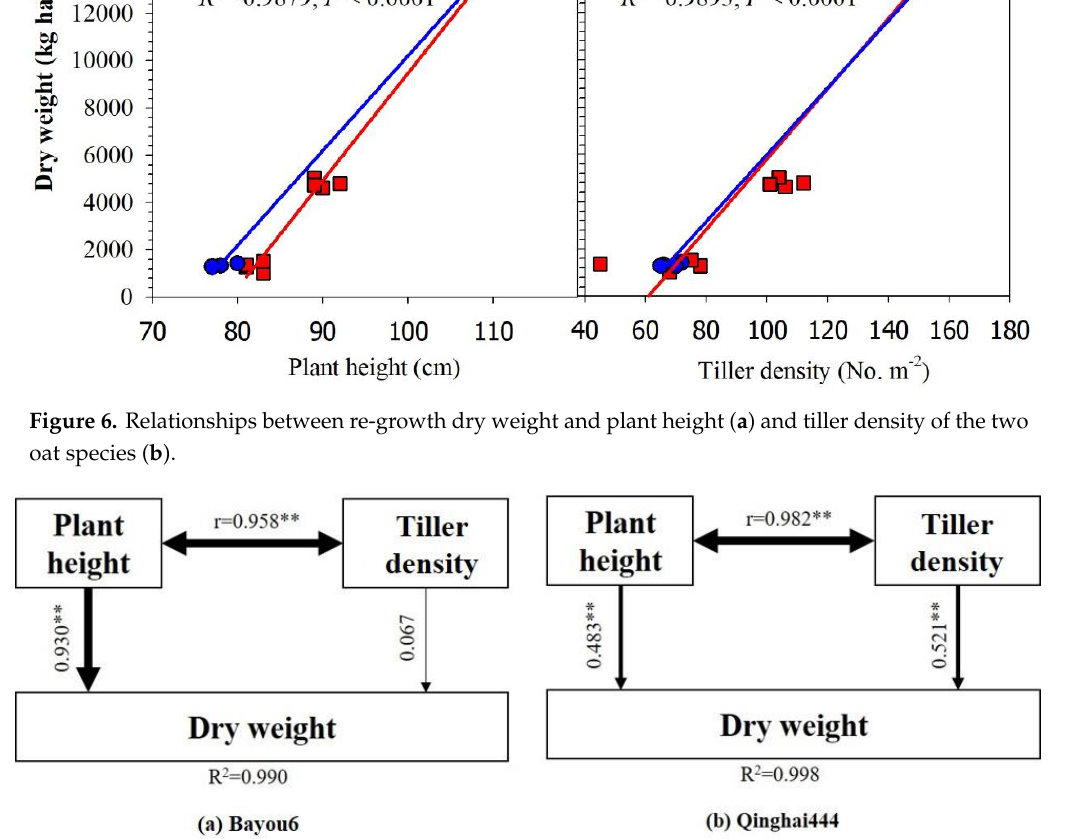
Figure 7. Structural equation models (SEMs) of re-grown dry weight via plant height, tiller density. Values associated with single-headed arrows are the direct path coefficients. Values associated with double-headed arrows indicate the correlation coefficients. ** indicates a significant difference at p < 0.01.